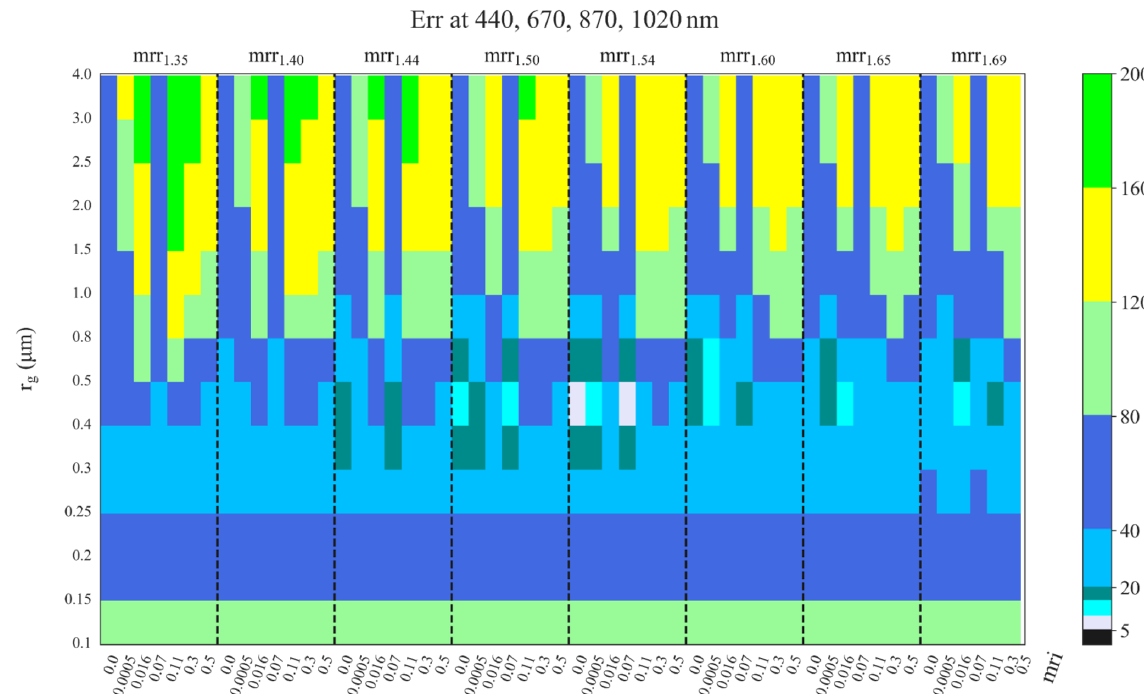
Figure 14. The residual error (Err) of fitting the phase functions at 440, 670, 870 and 1020nm of the near-spherical particles presented in the paper, with the phase functions calculated with the AERONET non-spherical model for radius r g and complex refractive index m shown on the y and x axes,